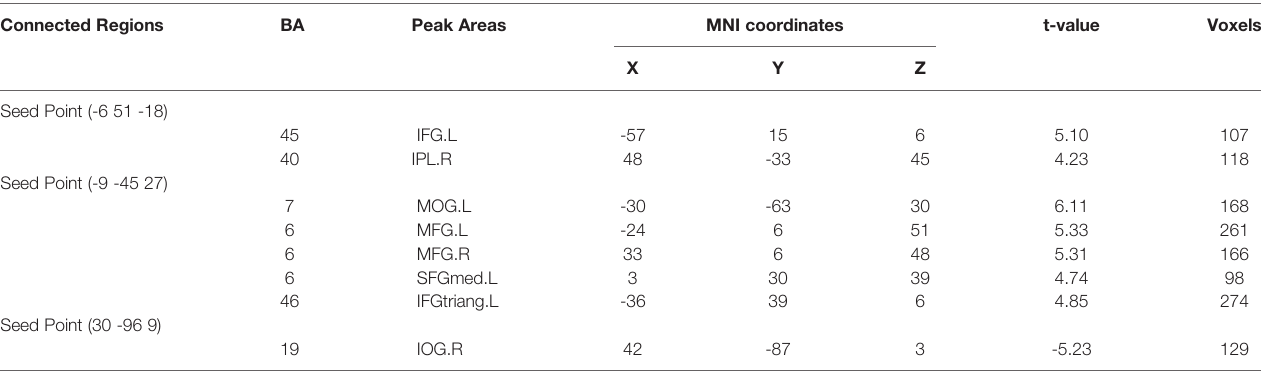
TABLE 3 | FC alterations between the two groups. Connected Regions